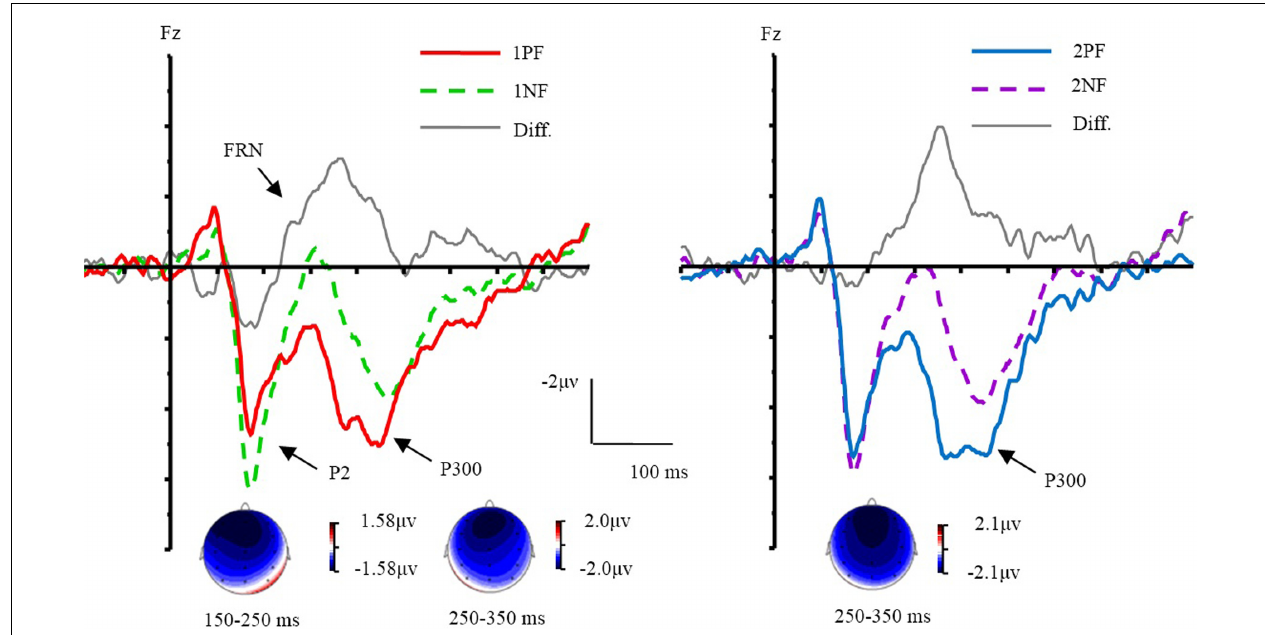
FIGURE 3 | The effect of valence and topographical distribution of the difference at P2 and FRN. Left, ERPs evoked by the first feedback; Right, ERPs evoked by the second feedback.